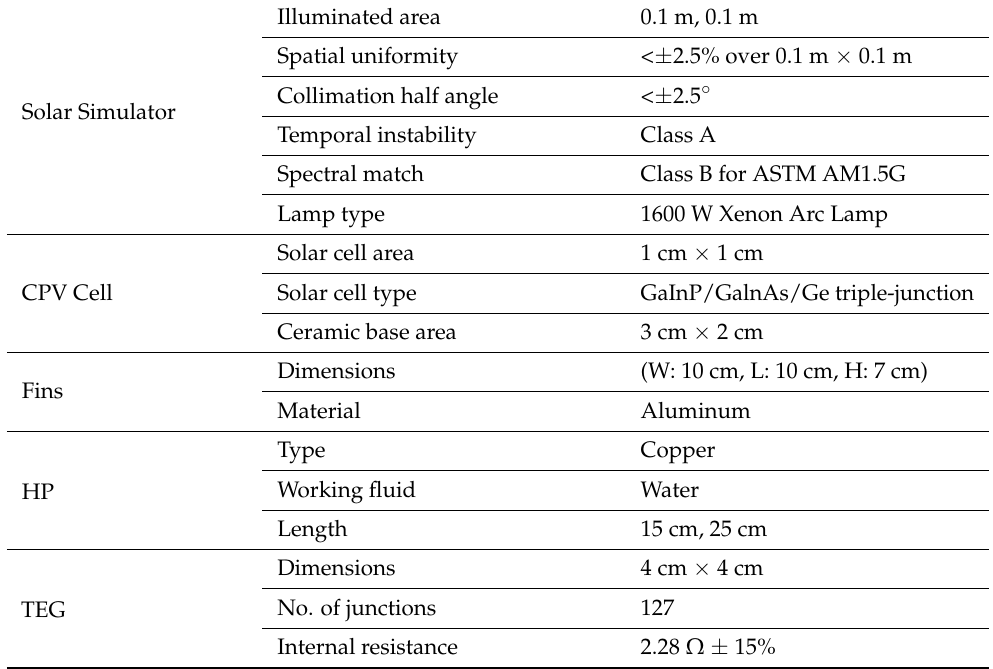
Table 1. Description and dimensions of setup